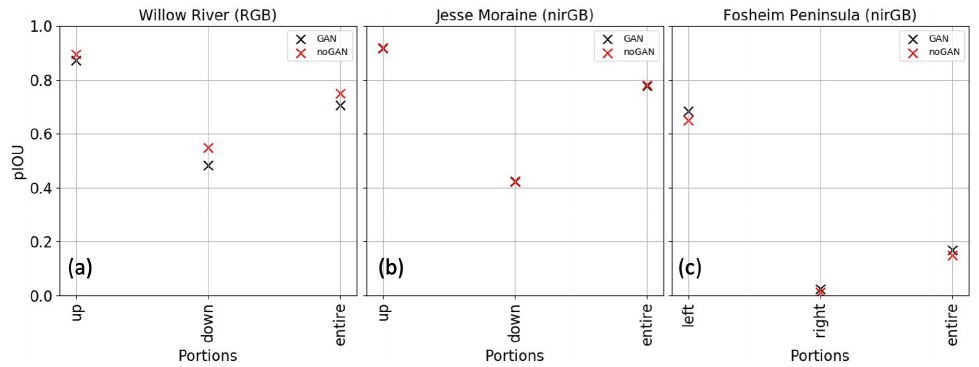
Figure 12. Comparison of the accuracy (pIOU) among experiments with and without GAN domain adaptation for different parts of the images in one region. ( a – c ) show the accuracies of different